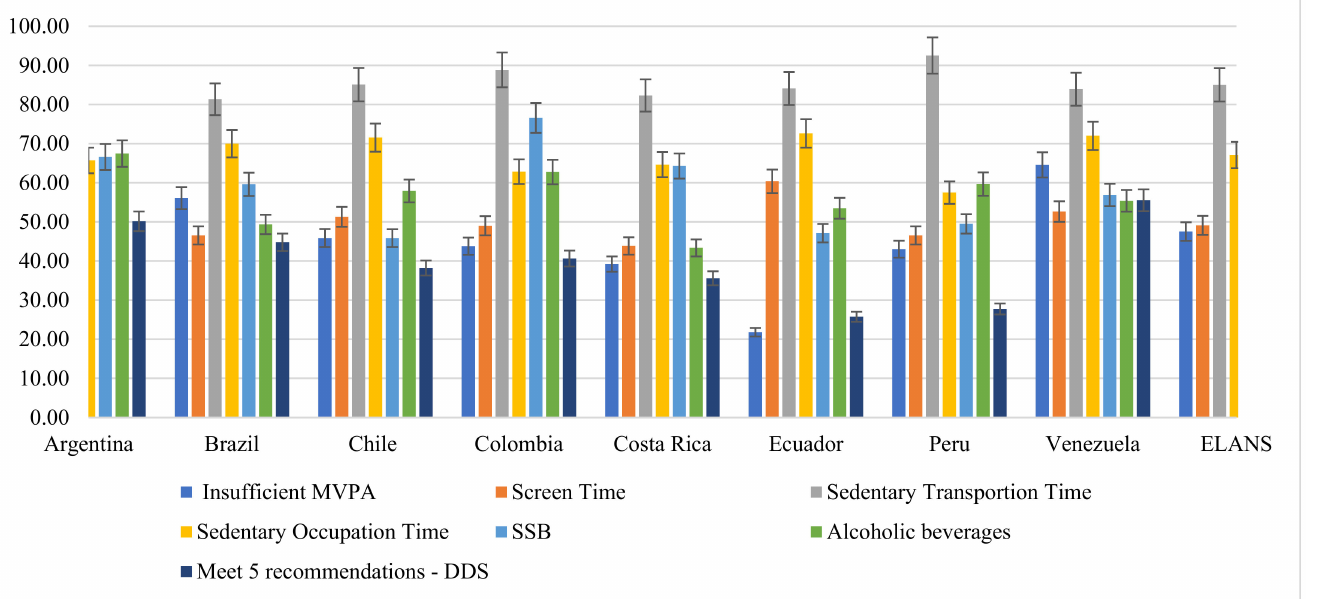
Figure 1. Prevalence (%) of sedentary, drinking behaviors and meeting the five recommendations for DDS in adolescents and adults from the Latin American Health and Nutrition Study (ELANS) ( n =